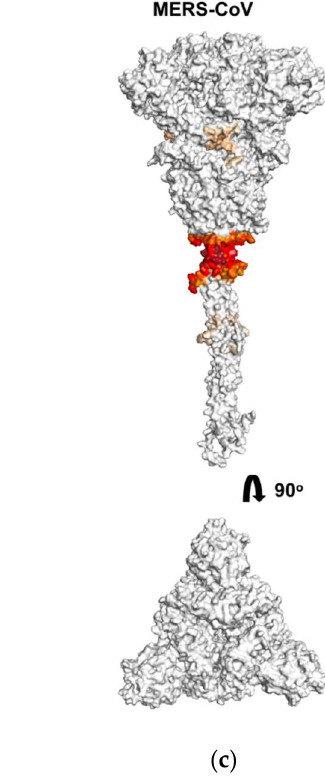
Figure 3. Molecular surfaces of coronavirus spike proteins of SARS-CoV ( a ), SARS-CoV-2 ( b ), and MERS-CoV ( c ) with depicted areas of MB binding in the lateral view (upper panels) and in the top view (lower panels). The regions of PS interactions with S-proteins surfaces are colored by gradient from orange to red in dependence of contact probability. The inset shows one possible energetically favorable position of MB molecule (colored in green) in the binding cavity.